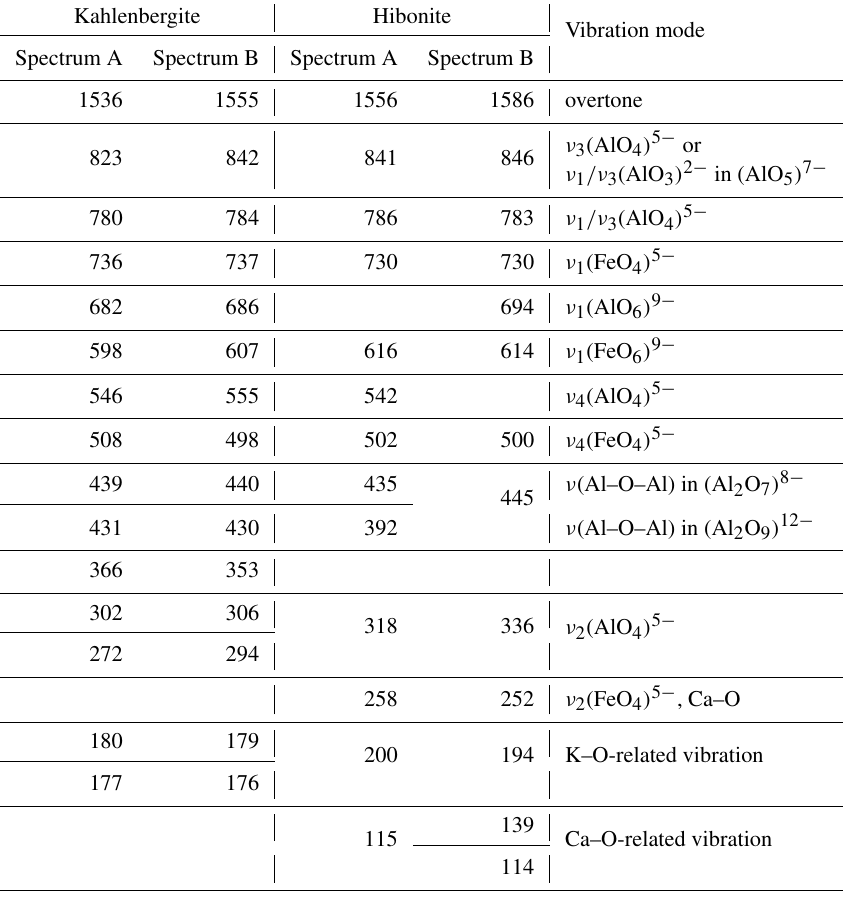
Table 3. Raman bands of kahlenbergite and hibonite (cm − 1